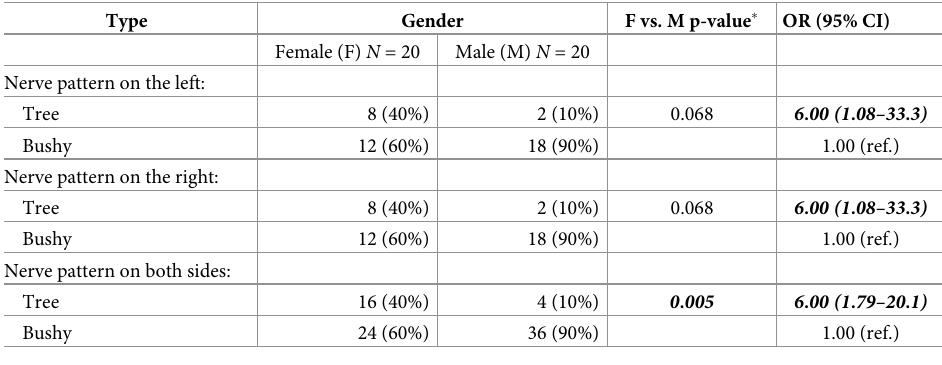
Table 2. Prevalence of superior gluteal nerve patterns in respect to sex and laterality. The bold and italic text shows a statistically significant